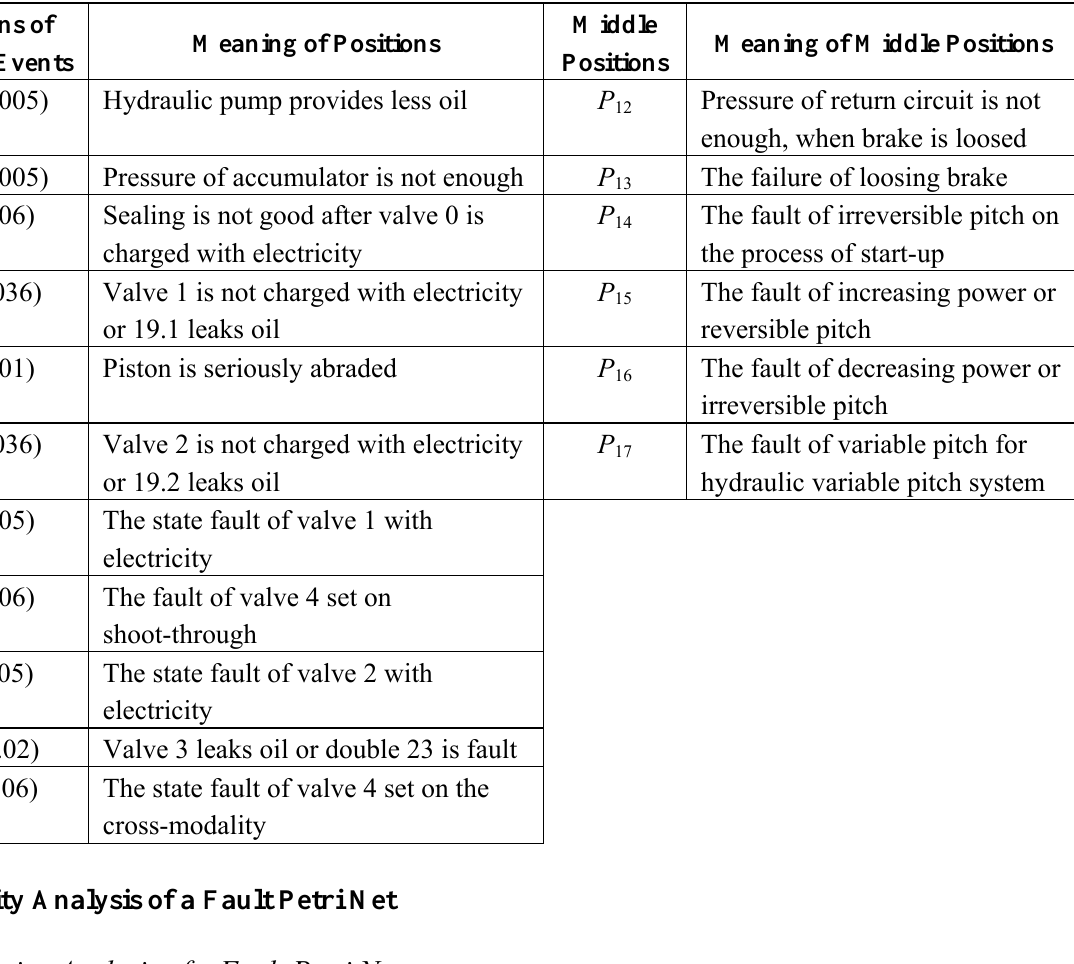
Table 2. Meaning and fault probability of each component place of hydraulic variable pitch